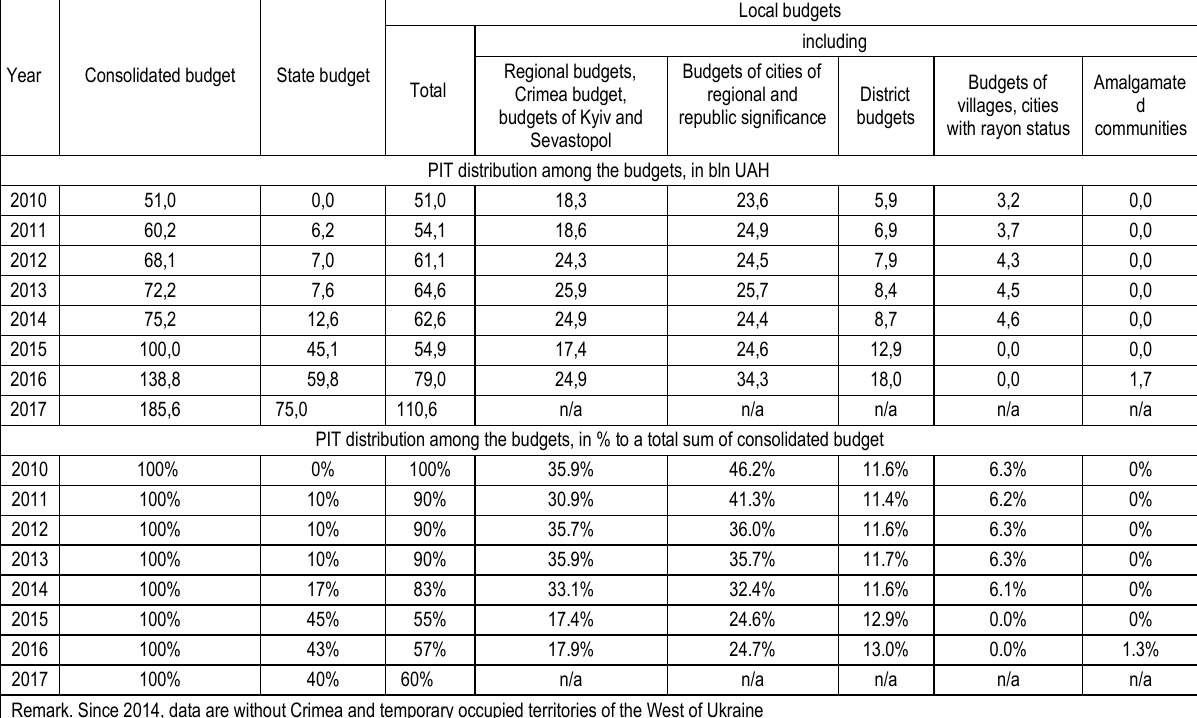
Table 3. Dynamics of the PIT distribution among the budgets in 2010 ˗ 2017, in bln UAH and % Year Consolidated budget State budget